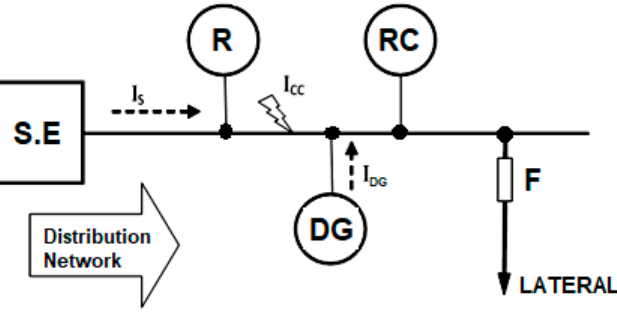
Figure 1. Sketch of a short circuit upstream of DG.